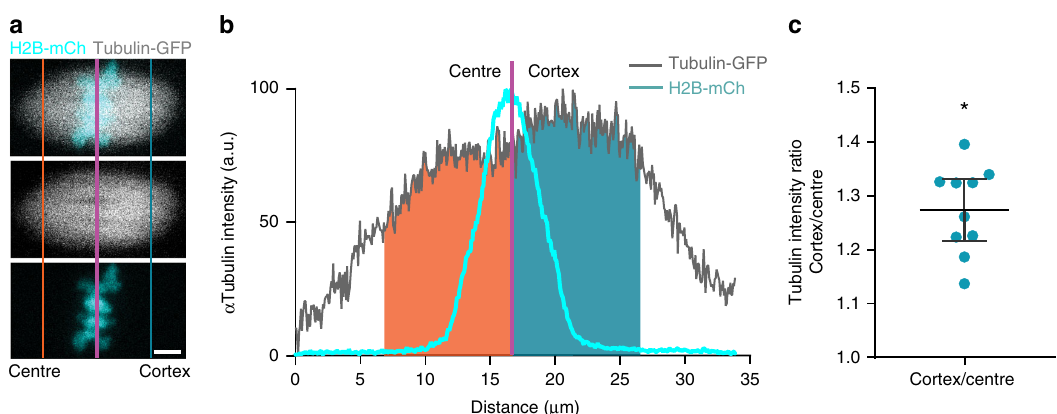
Fig. 5 Oocyte spindle asymmetry in microtubule tubulin density. a Representative image of microtubules ( α -tubulin-GFP, grey) and chromatin (H2B- mCherry, cyan) in an oocyte at 7 h after NEBD. Purple line indicates mean-weighted position of the bivalents; blue and orange lines indicate 10 µ m distance on the cortical and central side of the bivalents, respectively. Scale bar, 5 µ m. b α -Tubulin intensity pro fi le, in the x -axis, of the spindle (grey) and bivalents (cyan) is shown in a . Total α -tubulin intensity within 10 µ m of the bivalents on the central (orange) and cortical (blue) spindles halves. c Cortical/central ratio of α -tubulin fl uorescent intensity as shown in b (mean 1.274). * P < 0.05, 95% con fi dence intervals shown from 1.217 to 1.332 (i.e. >1.0); n = 10 oocytes, combined from two independent